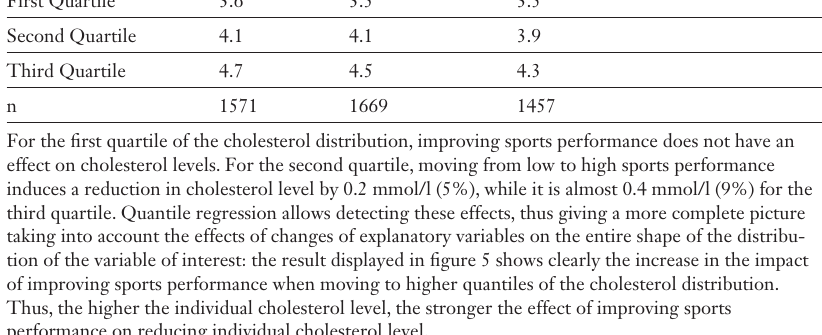
Cholesterol Distribu- tion (mmol/l) condi- tional on Sports